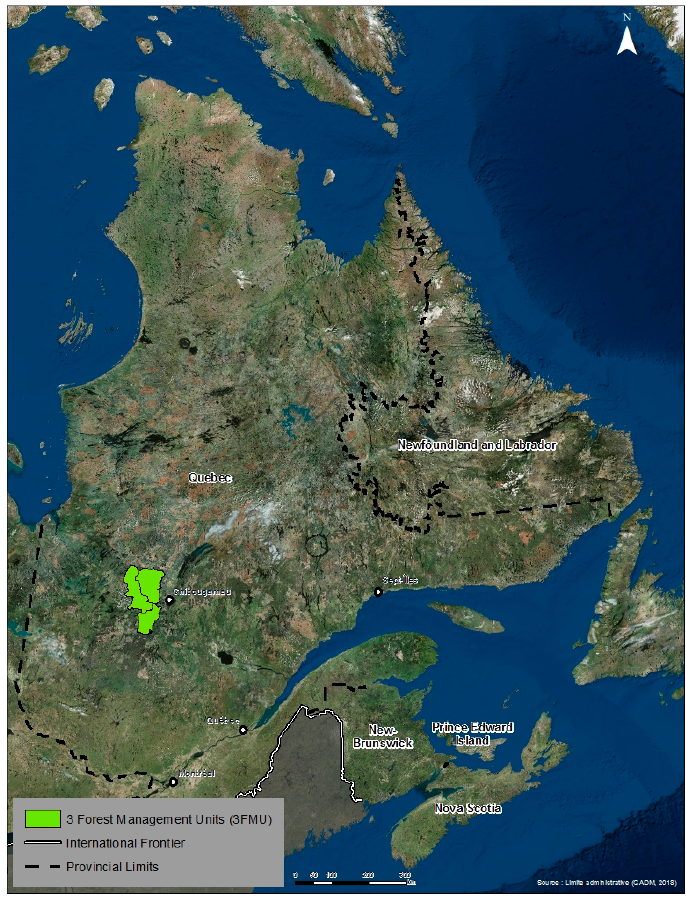
Figure 4. Test area localization.